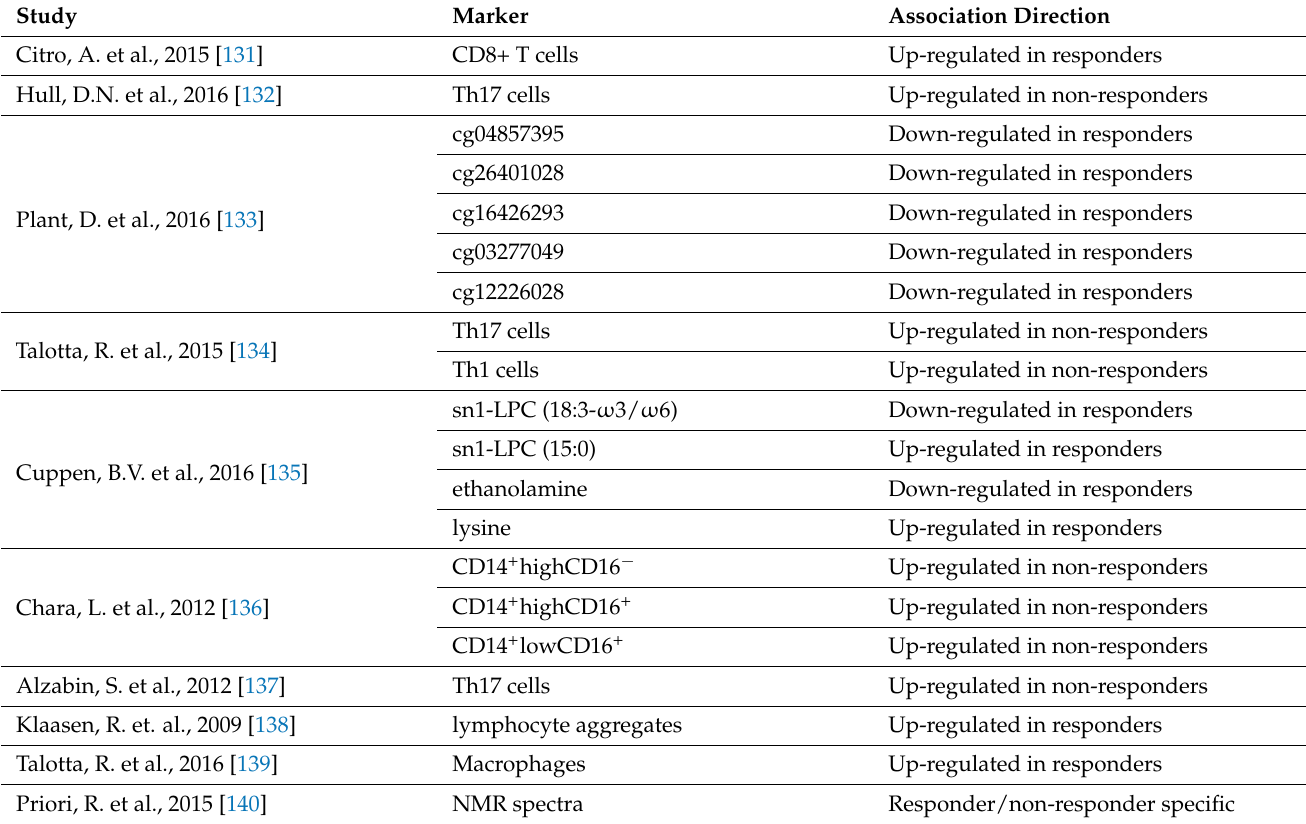
Table 5. Markers which count not be categorized as DNA, RNA or protein